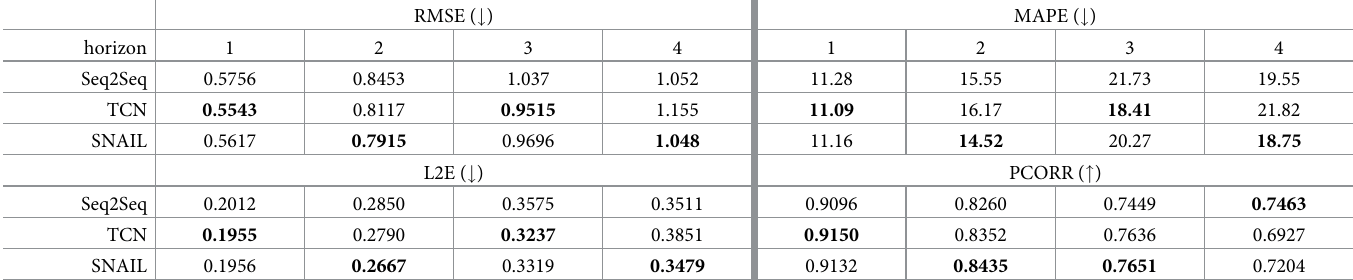
Table 4. The performance metrics computed using Seq2Seq, TCN, and SNAIL for varying prediction horizons {1, 2, 3, 4}. The same sets of network hyperparameters for each model are used for varying horizons. The downward/upward arrows in parentheses indicate smaller/larger values are preferred. RMSE ( # ) horizon